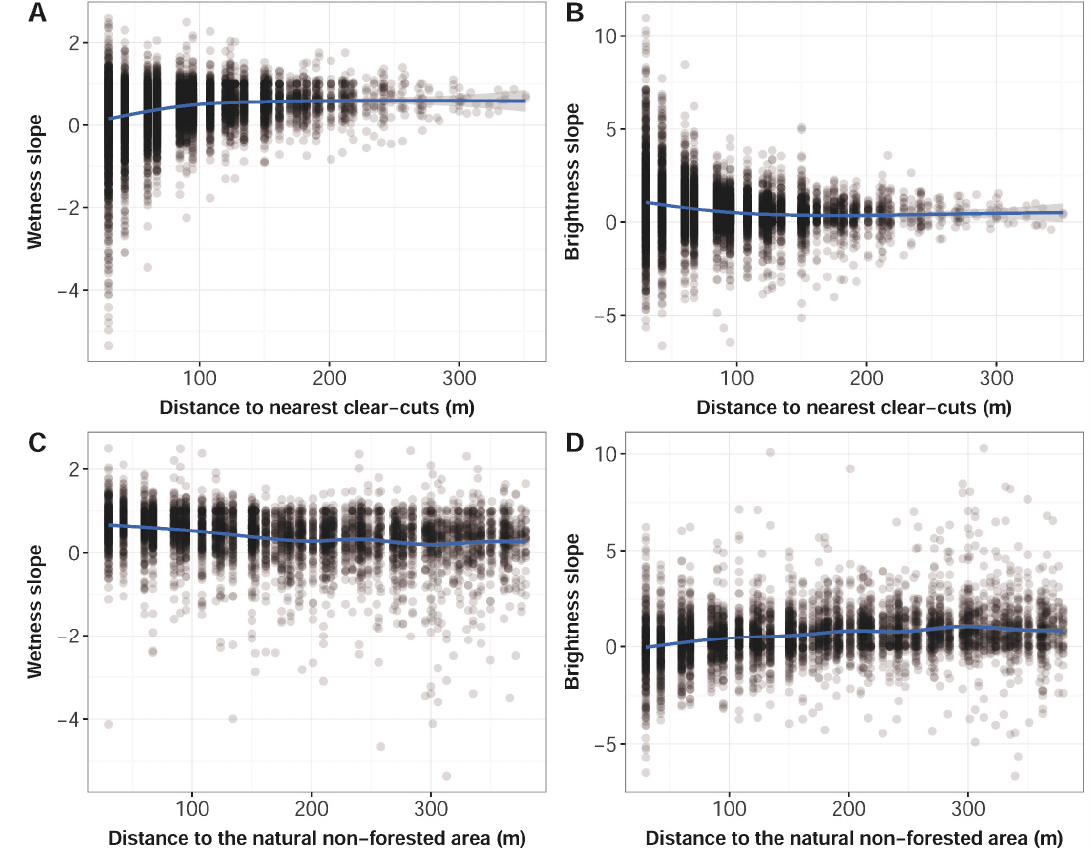
Figure 4. Wetness slope and Brightness slope values as they vary with distance to the nearest clear-cuts ( A , B ) and natural non-forested areas ( C , D ). The trend (blue line) of slope among distances is visualized using local polynomial regression (loess) ± 1 standard error mean (grey